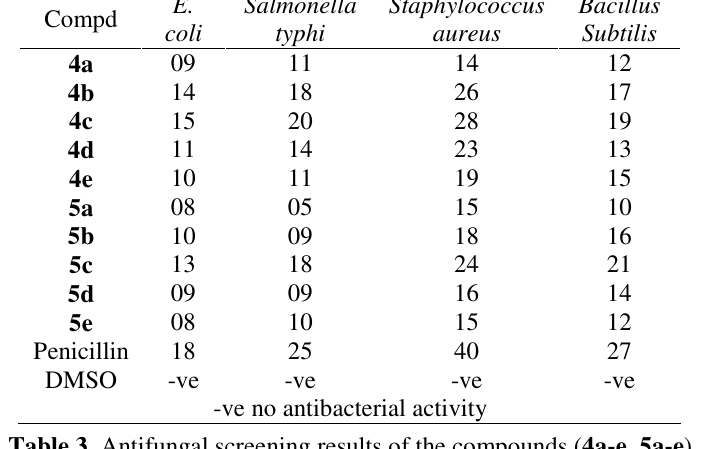
Table 3. Antifungal screening results of the compounds ( 4a-e, 5a-e )